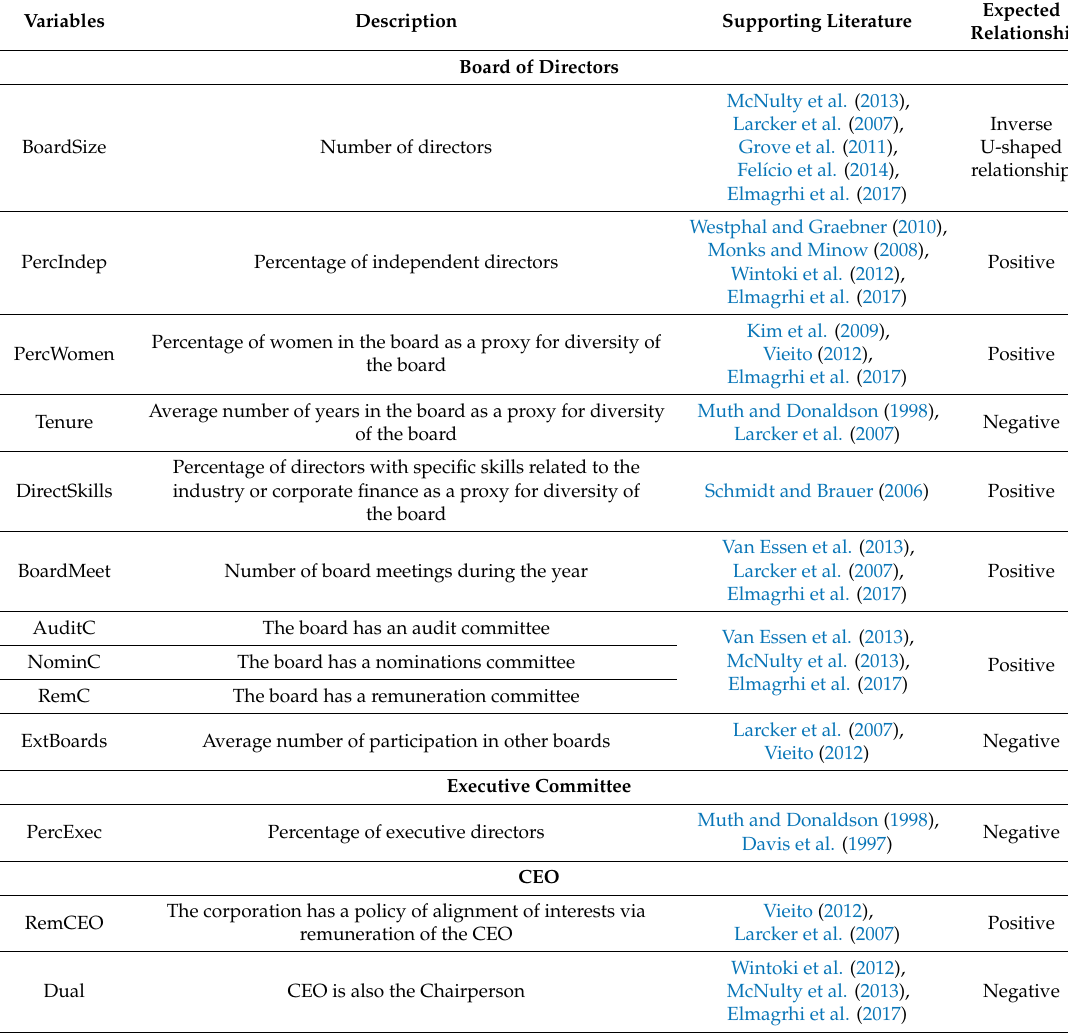
Table 1. Variables used in the research, identifying the supporting literature and the expected relationship with